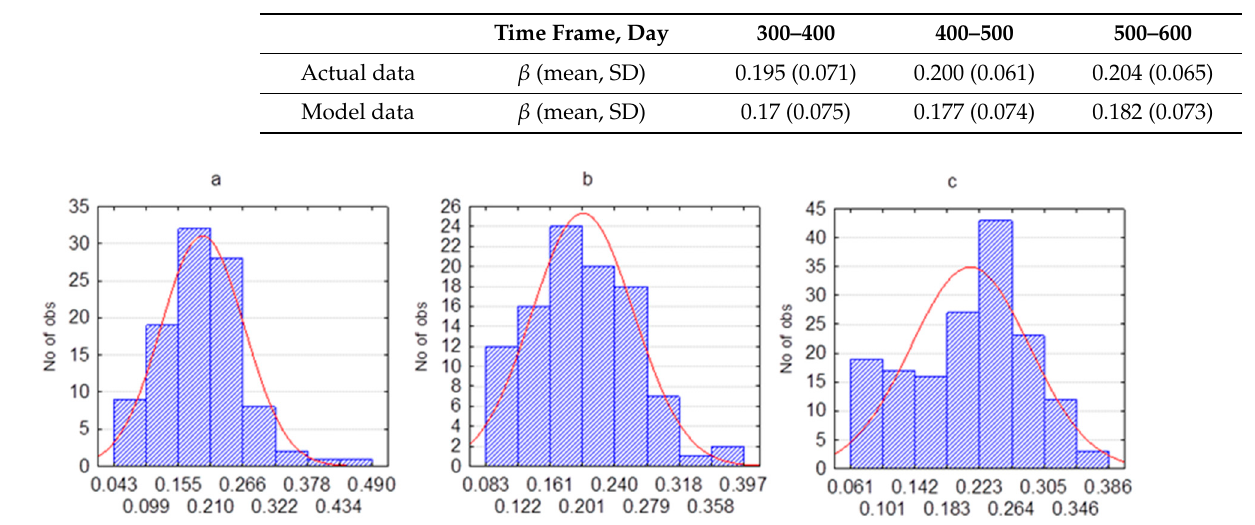
Table 4. Transmission rate statistical characteristics for actual and modeled data.